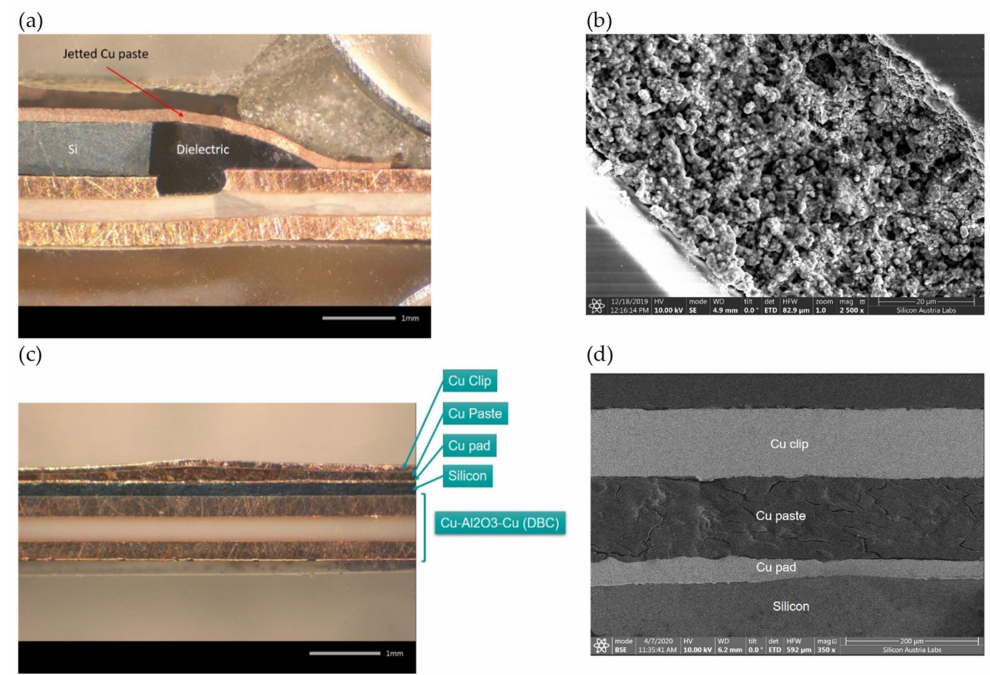
Figure 3. Cross-sectional analysis of sinterconnects; structure B with printed Cu- sinter paste ( a , b ) and structure C with printed Cu clip-attach ( c , d ).